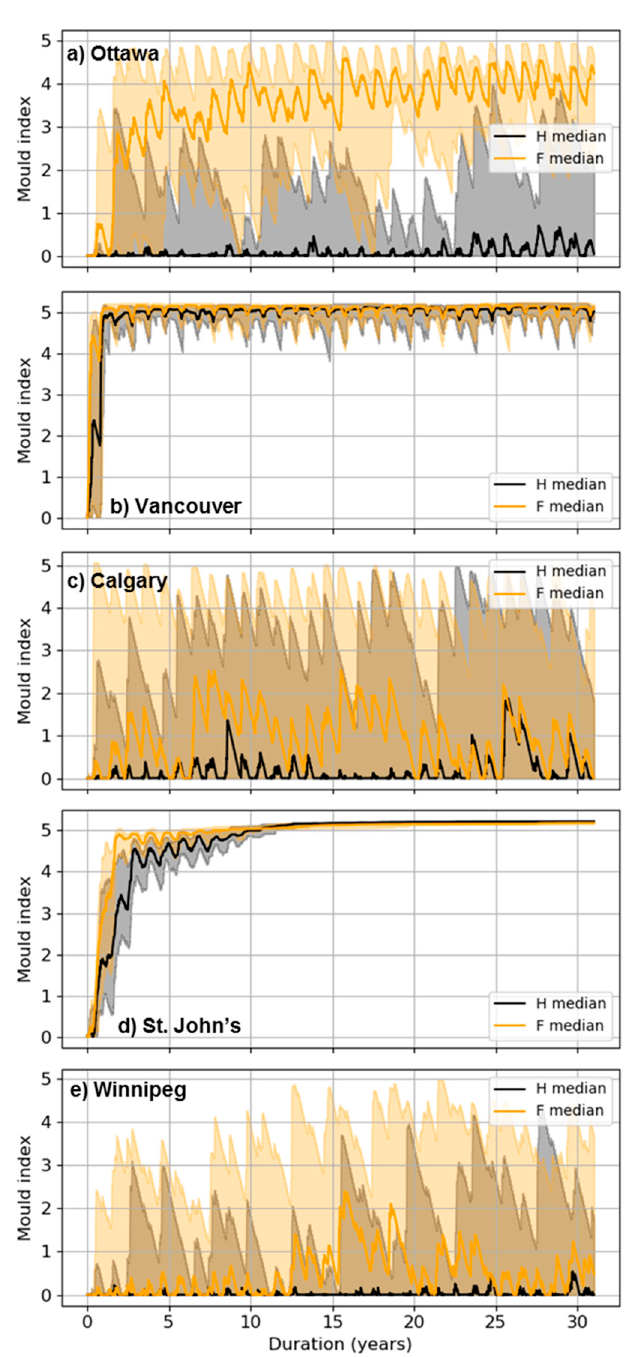
Figure 4. Mold index profiles obtained under the historical (H) and future (F) time periods in the city of Ottawa. The error band (minimum and maximum of the hourly run values) represents the uncertainty due to the internal variability of the modeled climate data.